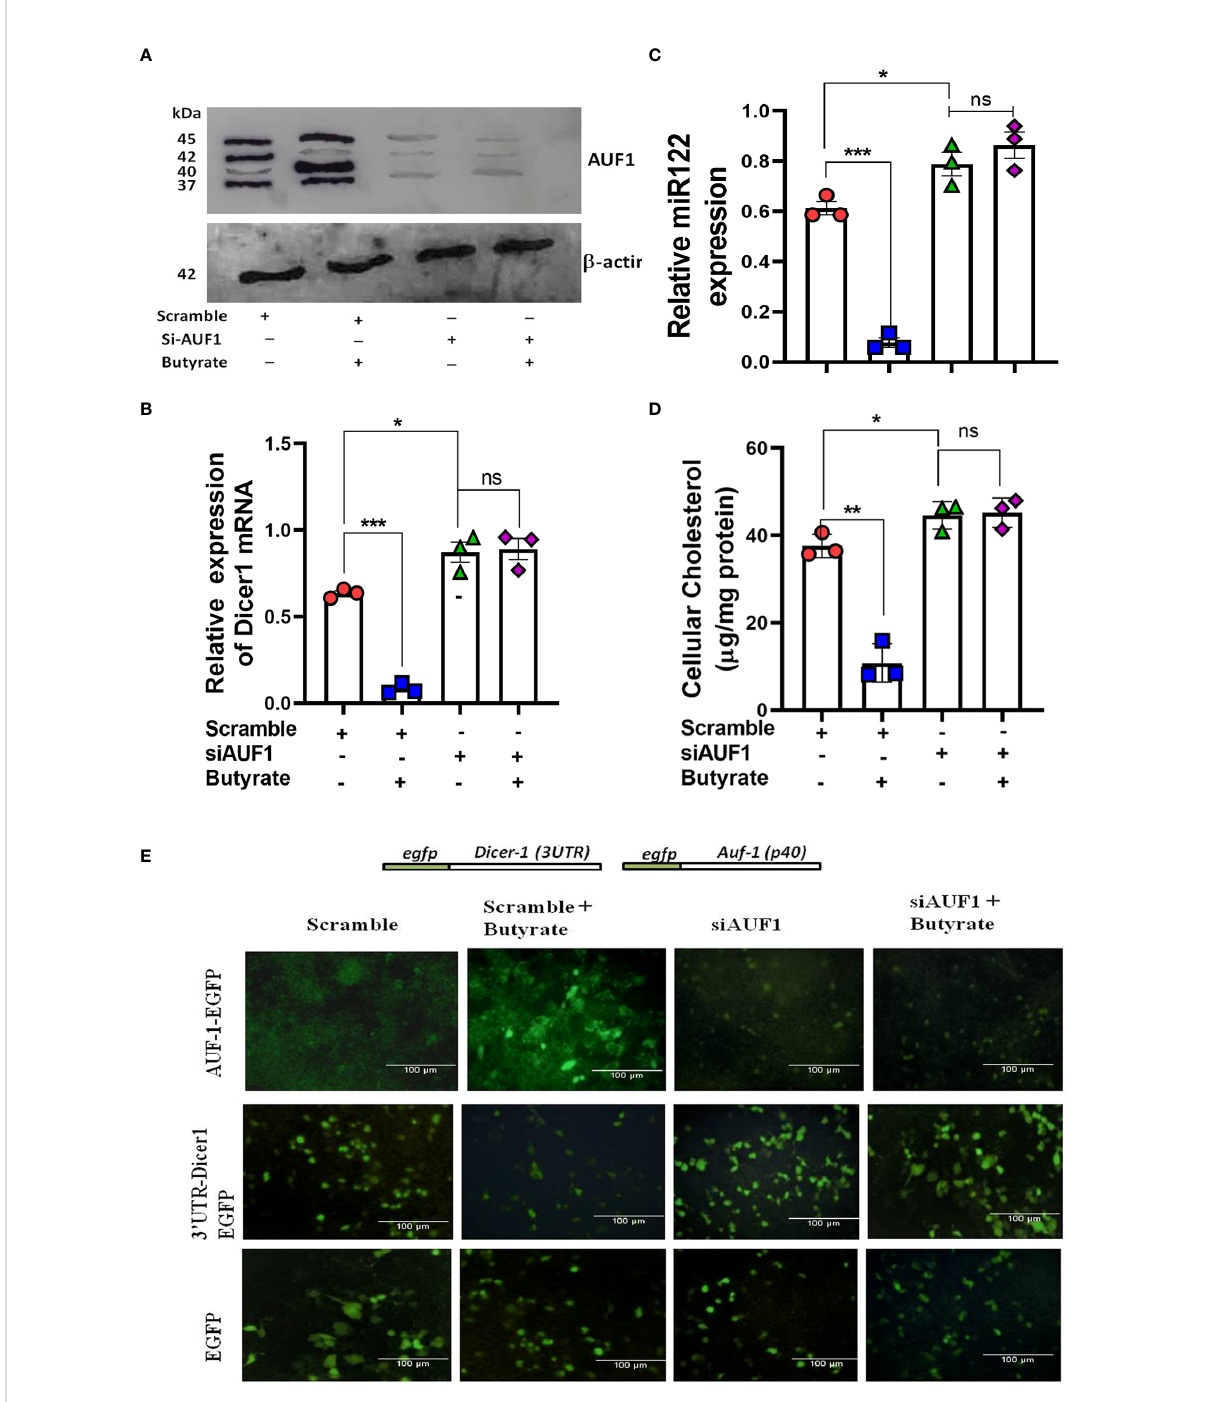
FIGURE 4 Silencing of AUF1 by siRNA-enhanced miR122, Dicer1 expression, and cellular cholesterol in Huh7 cells regardless of butyrate treatment. Western blot of AUF1 isoforms after co-transfecting with either siAUF1 or scramble-RNA (scramble) where b -actin is used as control (A) . The corresponding expression of Dicer1 (B) and miR122 (C) as analyzed by qPCR and cellular cholesterol in cell lysate (D) . Analysis of EGFP expression upon transfection with reporter construct of EGFP-AUF1 p40 , EGFP-3U ́ TR-Dicer1, and EGFP (from top to bottom) in a co-transfection experiment under the following conditions: (i) scramble, (ii) scramble plus 20 mM butyrate, (iii) siAUF1 alone, and (iv) siAUF1 plus 20 mM butyrate (from left to right) (E) . Resulting fl uorescence images of co-transfected cells were captured in 20× magni fi cation in a Carl Zeiss microscope equipped with a CCD camera controlled with ZEN software (Carl Zeiss, Gottingen, Germany). N = 3; the data are presented as mean ± SE. *** represents p < 0.001, ** represents p < 0.01, * represents p < 0.05, and ns represents not signi fi